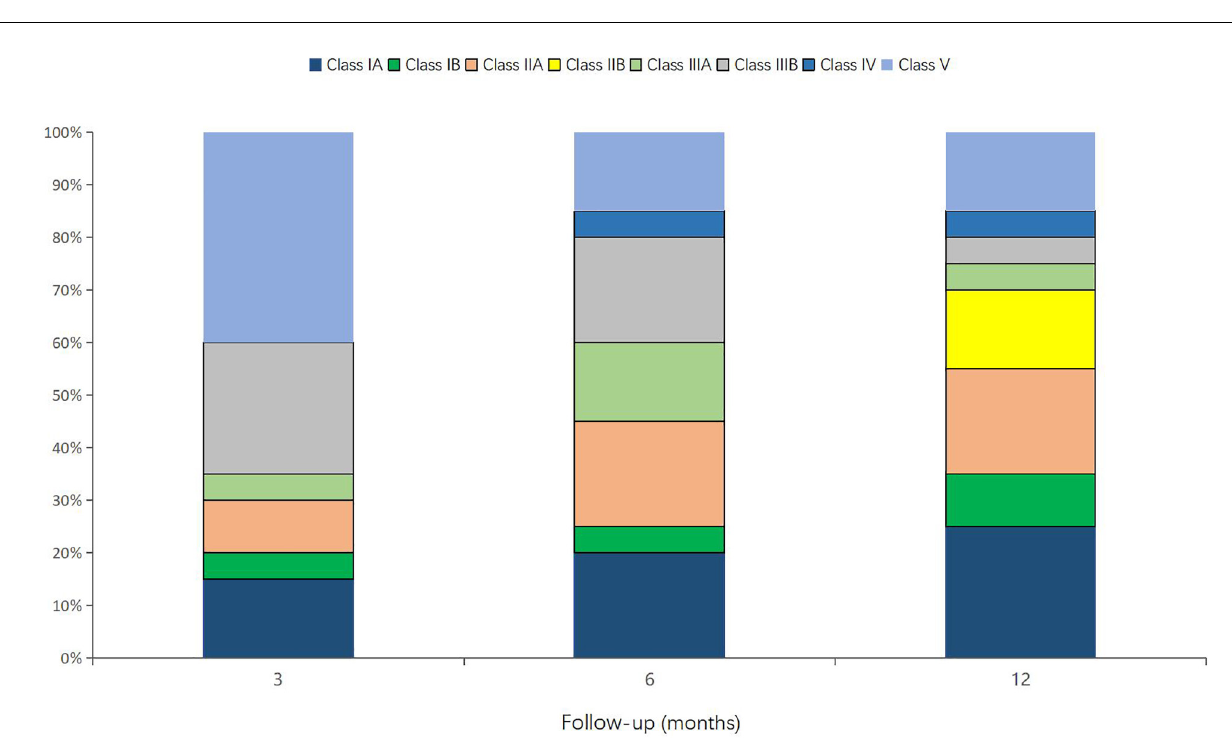
FIGURE 2 | McHugh classification percentage